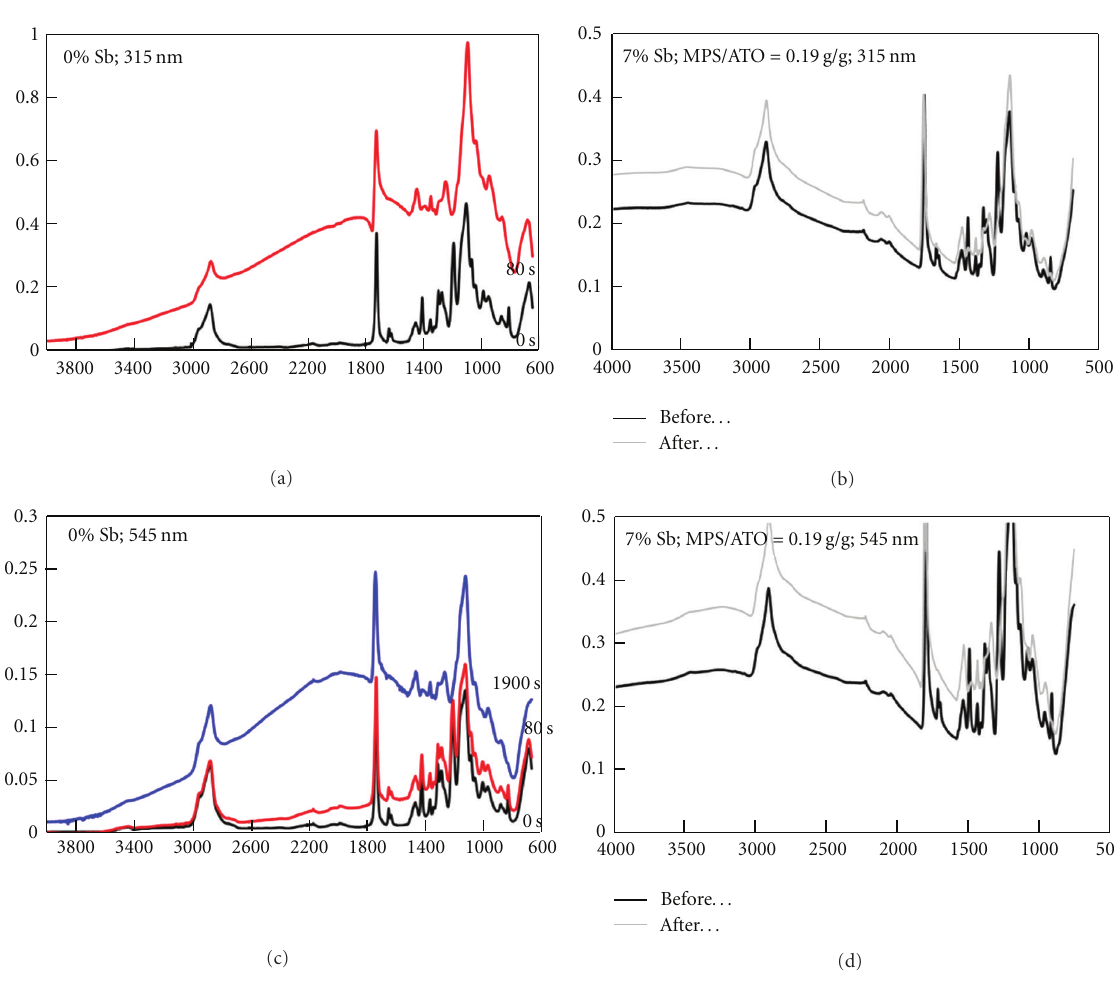
Figure 3: Infrared absorption spectra before and during irradiation of Sb:SnO 2 (Sb ≥ 0%)/PEGDA 575 formulations (Sb = 0% or Sb = 7%). MPS/Sb:SnO 2 = 0.19 g/g. Incident wavelength of radiation: 315 or 545 nm. The results obtained fusing incident radiation of 365, 408 or 650nm are